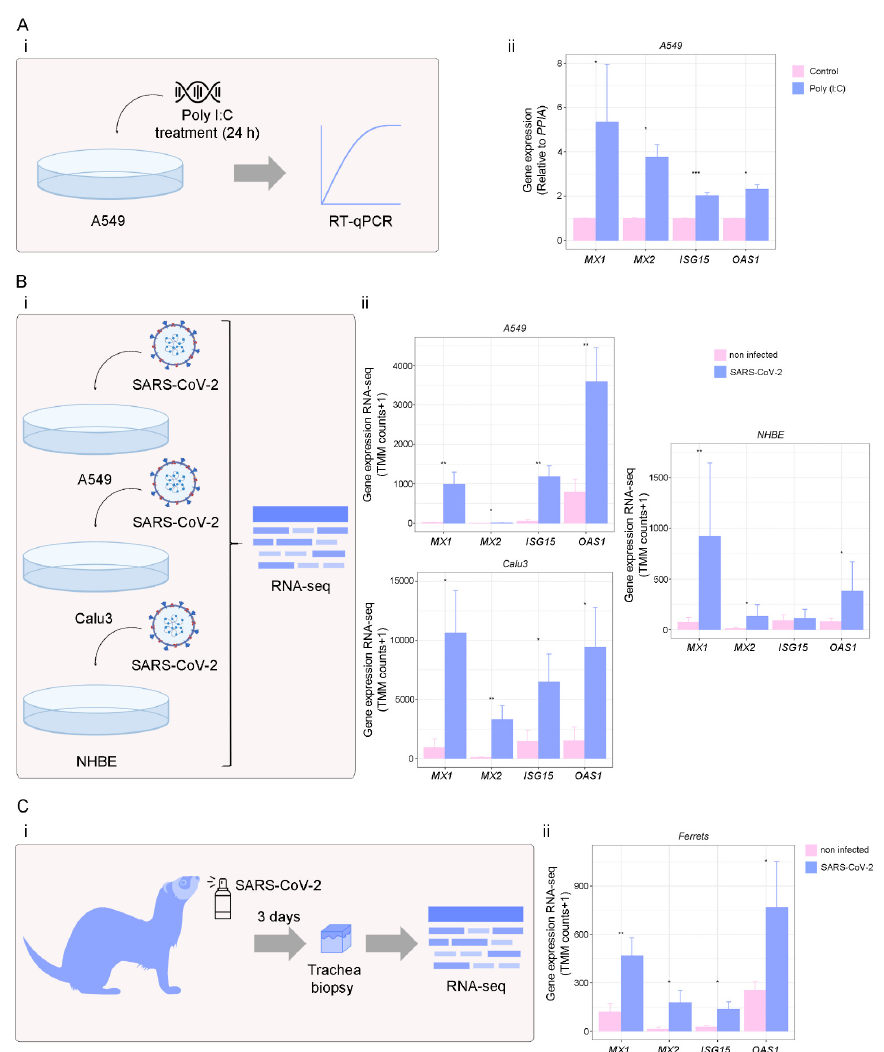
Figure 5. Analysis of ISGs expression in viral infections. ( A ) A549 cells were treated with Poly (I:C) for 24 h, and RNA was extracted for RT-qPCR analysis. (i) Schematic representation of the experimental design. (ii) MX1 , MX2 , ISG15 , and OAS1 expressions assessed by RT-qPCR in A549 cells treated (purple) or not (pink) with Poly (I:C) (10 µ g/ml; 24 h). Values were relativized using PPIA as a reference gene and normalized to the control. ( B ) MX1 , MX2 , ISG15 , and OAS1 expressions (norm counts +1) in SARS-CoV-2-treated cells. (i) Schematic representation of the experimental design. (ii) MX1 , MX2 , ISG15 , and OAS1 expressions in SARS-CoV-2-infected A549 (n = 6), Calu3 (n = 6), and NHBE (n = 10) cell lines (purple) (MOIs: 0.2, 2, and 2, respectively for 48 h) compared with mock (pink), assessed by RNA-seq, using the GSE147507 dataset. ( C ) MX1 , MX2 , ISG15 , and OAS1 expressions (norm counts +1) in SARS-CoV-2-treated ferrets. (i) Schematic representation of the experimental design. (ii) MX1 , MX2 , ISG15 , and OAS1 expressions in SARS-CoV-2-infected (5 × 10 4 PFU) (purple) vs. mock-treated (pink) ferrets, assessed by RNA-seq in tracheal biopsy samples (n = 7), using the GSE147507 dataset. Samples were collected on day 3 after SARS-CoV-2 infection. Student’s t -test was performed to determine statistical differences. Statistical significance * p < 0.05; ** p < 0.01; *** p <